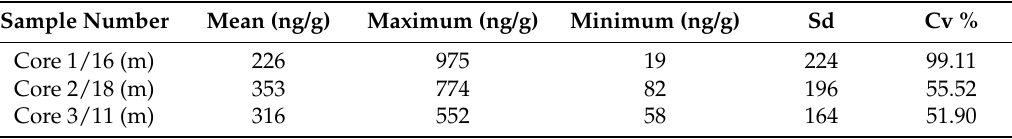
Table 1. THg concentration of core samples in each